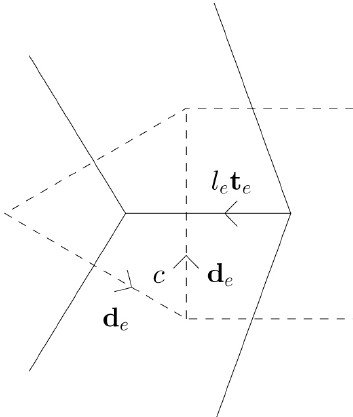
Figure A1. Schematic illustrating some of the grid elements used in the construction of the H operator on the cubed